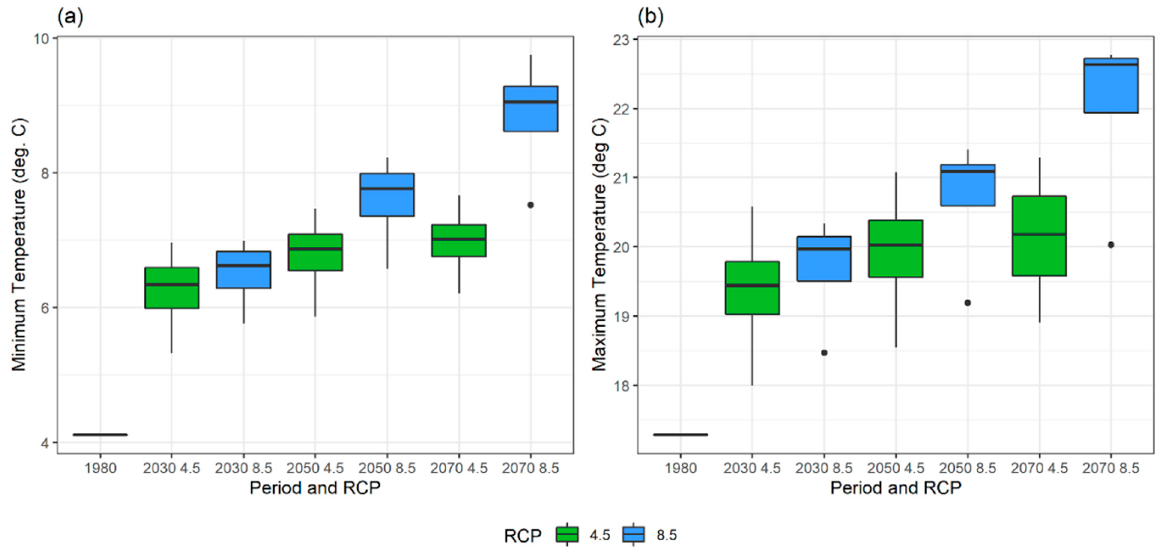
Figure 3. Projected annual temperature changes from ensemble mean for four GCM scenarios in ( a ) ( a ) minimum temperature ( ◦ C), and ( b ) maximum temperature ( ◦ C) for 3 future periods of 20-year minimum temperature (°C), and ( b ) maximum temperature (°C) for 3 future periods of 20-year in-